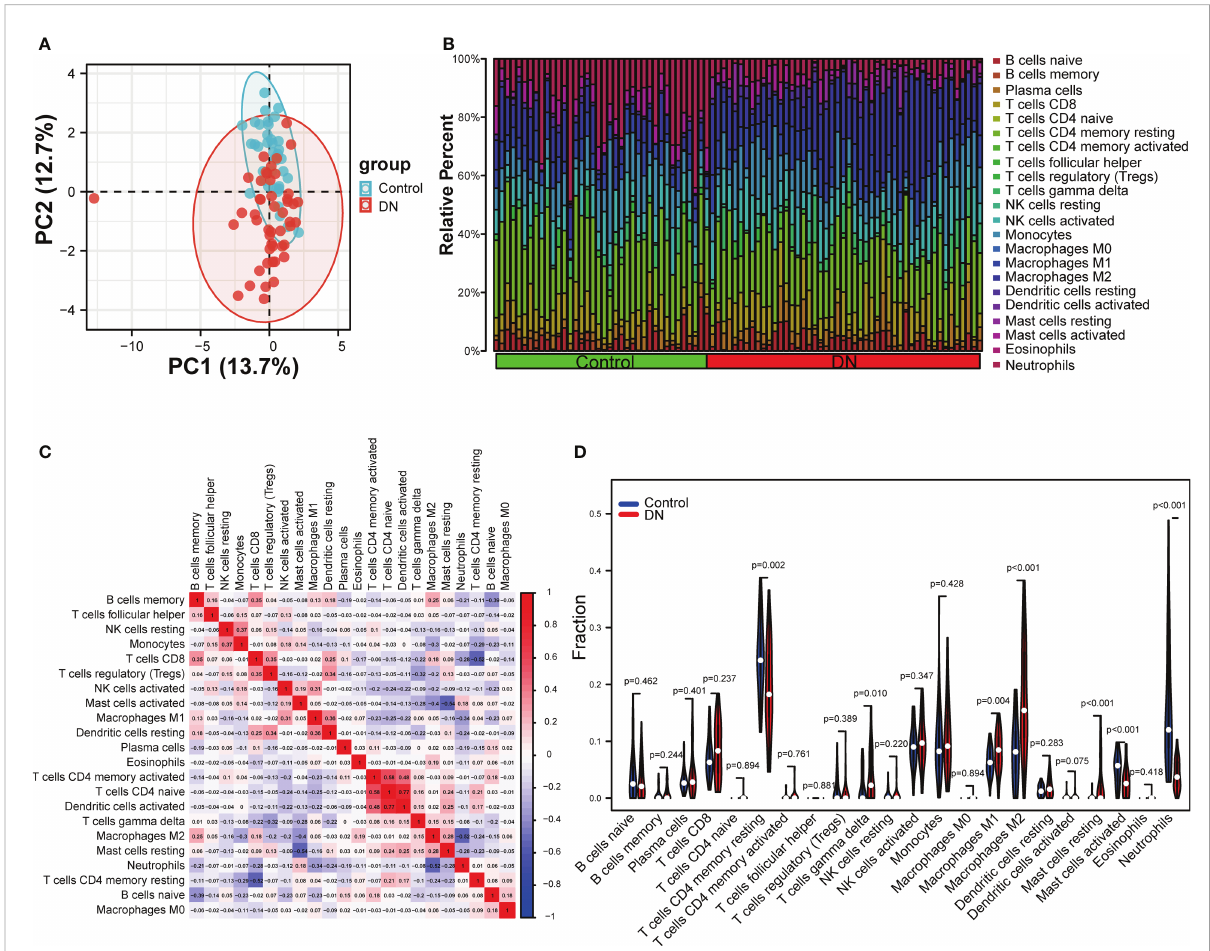
FIGURE 8 Evaluation and visualization of immune cell in fi ltration. (A) The PCA plot showing immune cell in fi ltration between DN and control samples. (B) Stacked histogram comparing DN and control samples for the immune cell percentage. (C) Correlation heat map of 22 types of immune cells. (D) Violin diagram showing 22 types of immune cells in proportion. Data were analyzed by Wilcoxon